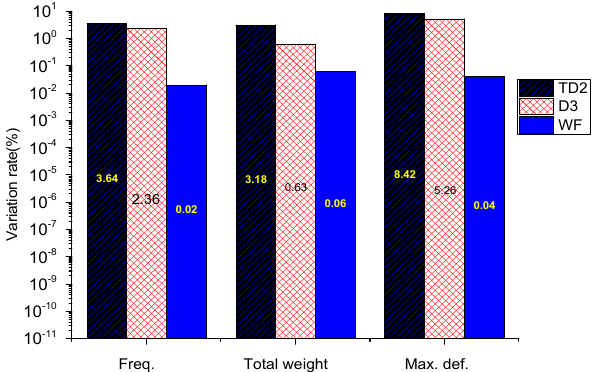
Figure 8. The variation rate of the structural responses with respect to the change of design variables.